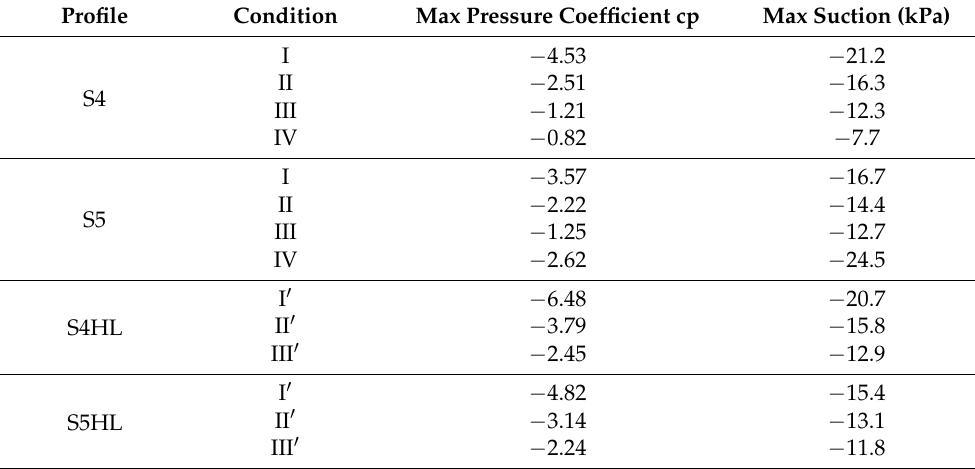
Figure 6. Pressure and flow ( left ) and c p distribution ( right ) for high-lift profile S5HL in three extreme conditions. Table 3. List of suction peak values in extreme conditions.